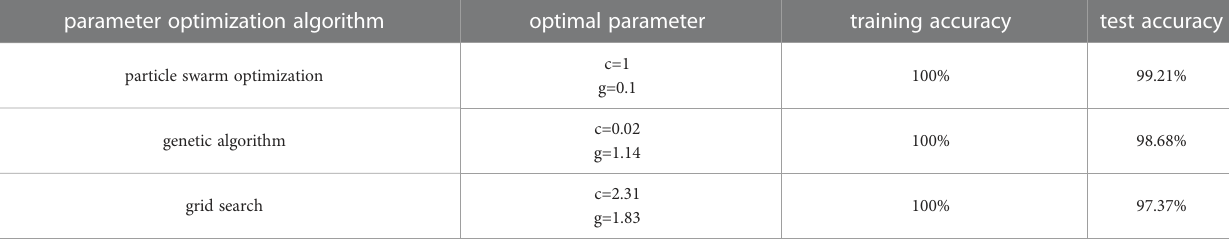
TABLE 3 Optimal parameters and test accuracy by using different